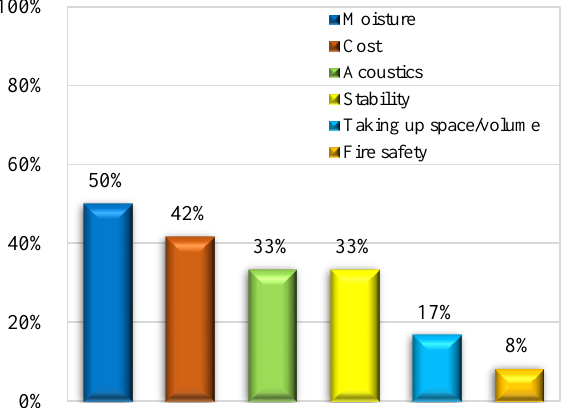
Figure 3. Disadvantages of constructing with wooden frames considered by ERs.